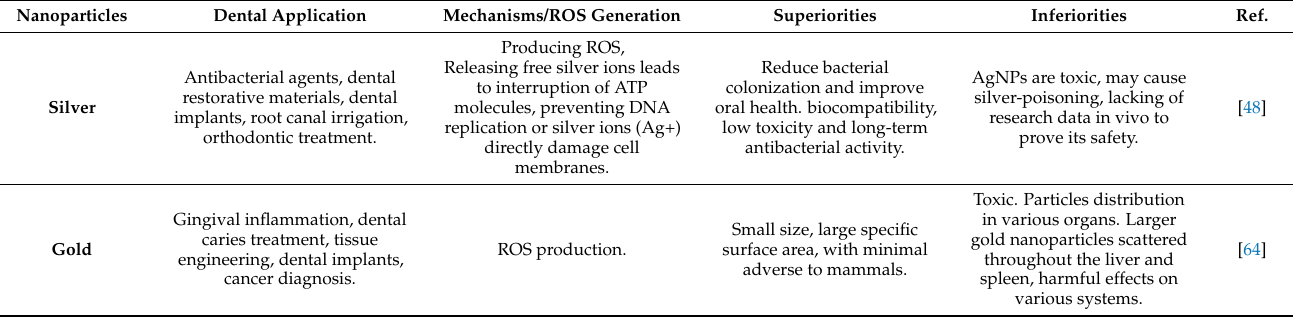
Table 2. Summary of ROS-based nanoparticles used in